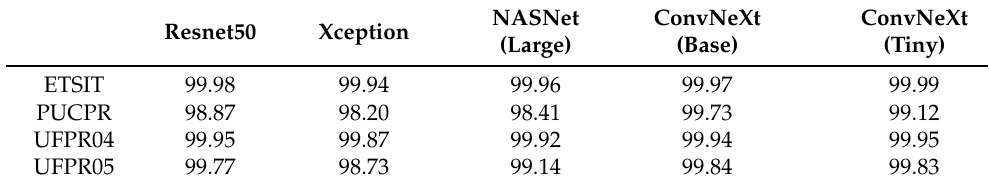
Table 3. Average accuracy of the proposed system for each of the tested backbones, computed with all the employed databases. Each column represents the accuracy performance given by one of the backbones, while each row indicates the accuracy obtained in a particular dataset.